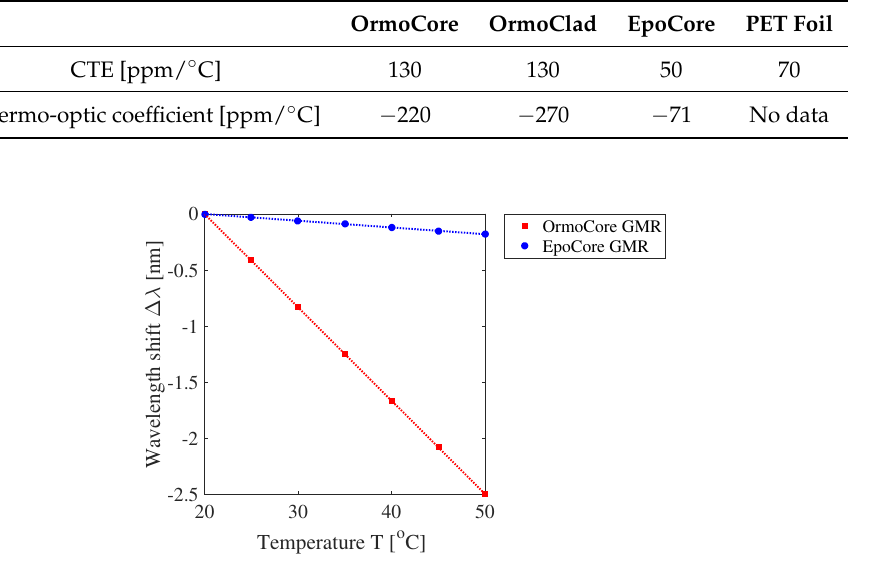
Figure 12. The simulated resonant wavelength shift ∆ λ as a function of the temperature T for the GMR grating in OrmoCore and EpoCore. The used grating parameters are listed in Table 1.